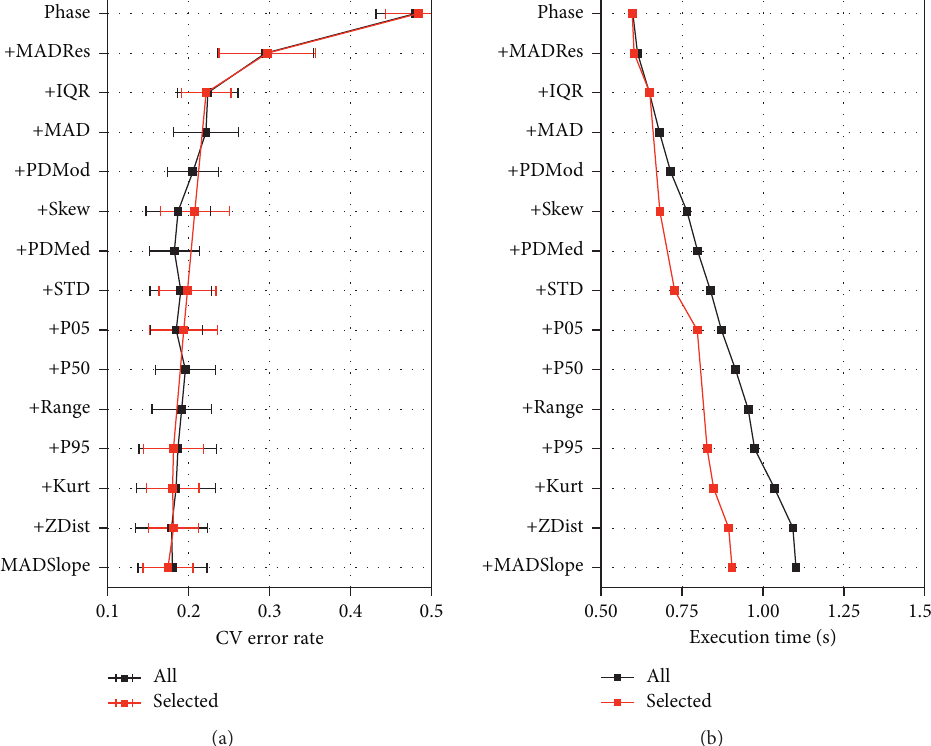
Figure 5: The evolution of cross-validation error rate as an additional feature is included in the classification (a). Execution time for each run is also displayed (b).